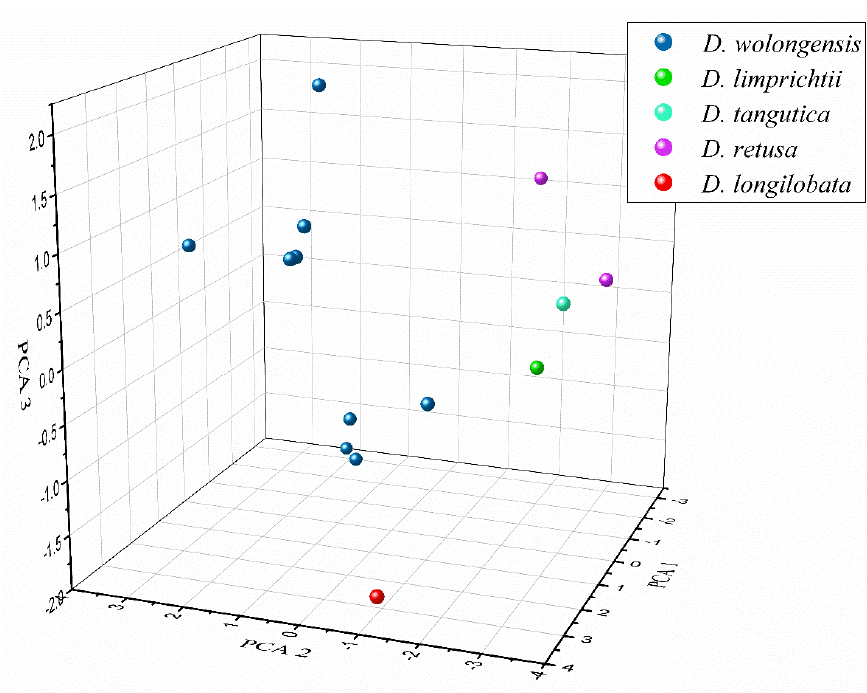
Figure 1. Principal Coordinate Analysis (PCoA) analysis of morphological data of Daphne spp.